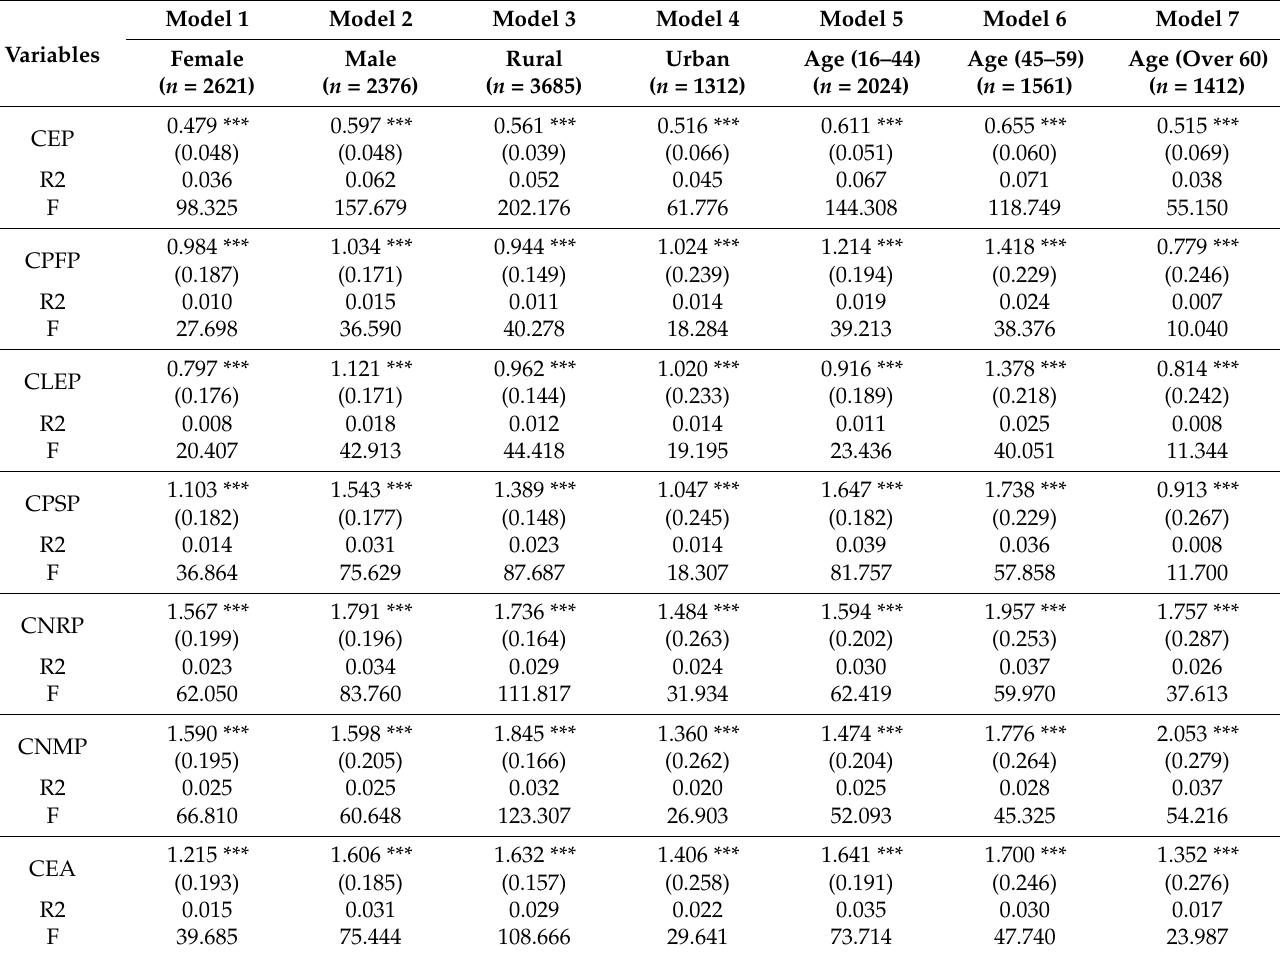
Table 3. Linear regression of CEP on depression in different